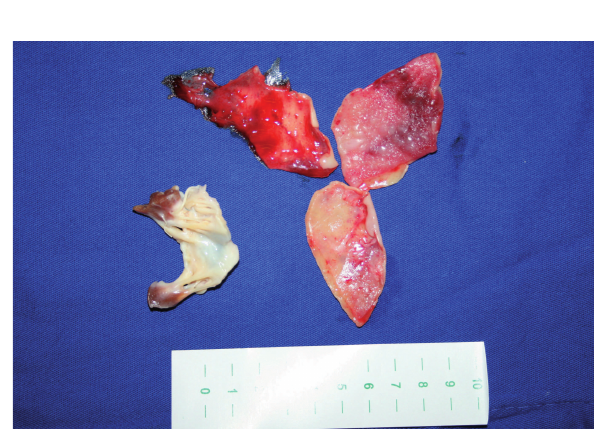
ressecçãoFig. Fig. 5 - Aspecto final da